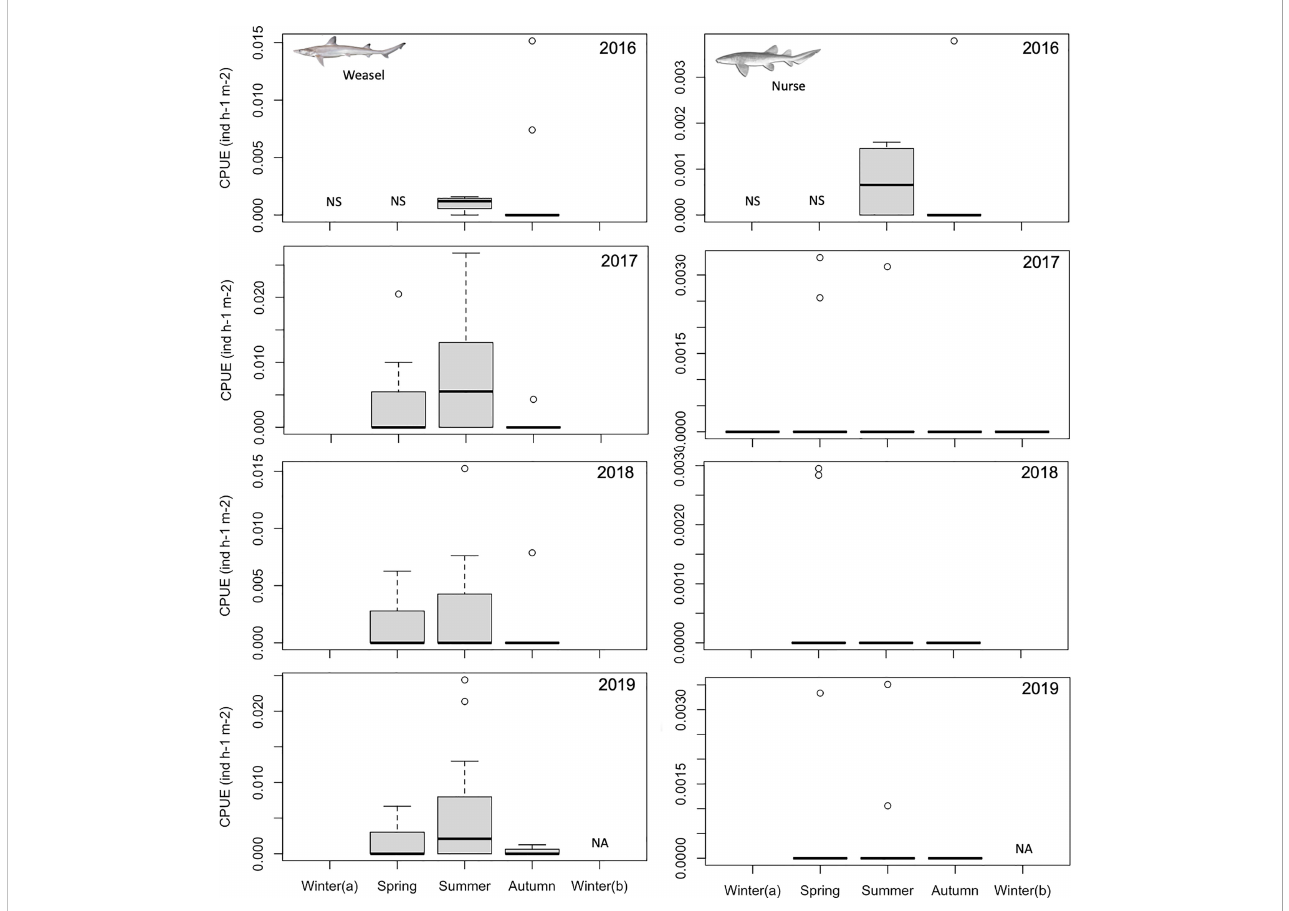
TABLE 1 Effects of time (year) and cyclic month effects on the catch per unit of effort (CPUE) for each of the fi ve shark species. Time Month R 2 deviance Species df p-value df p-value